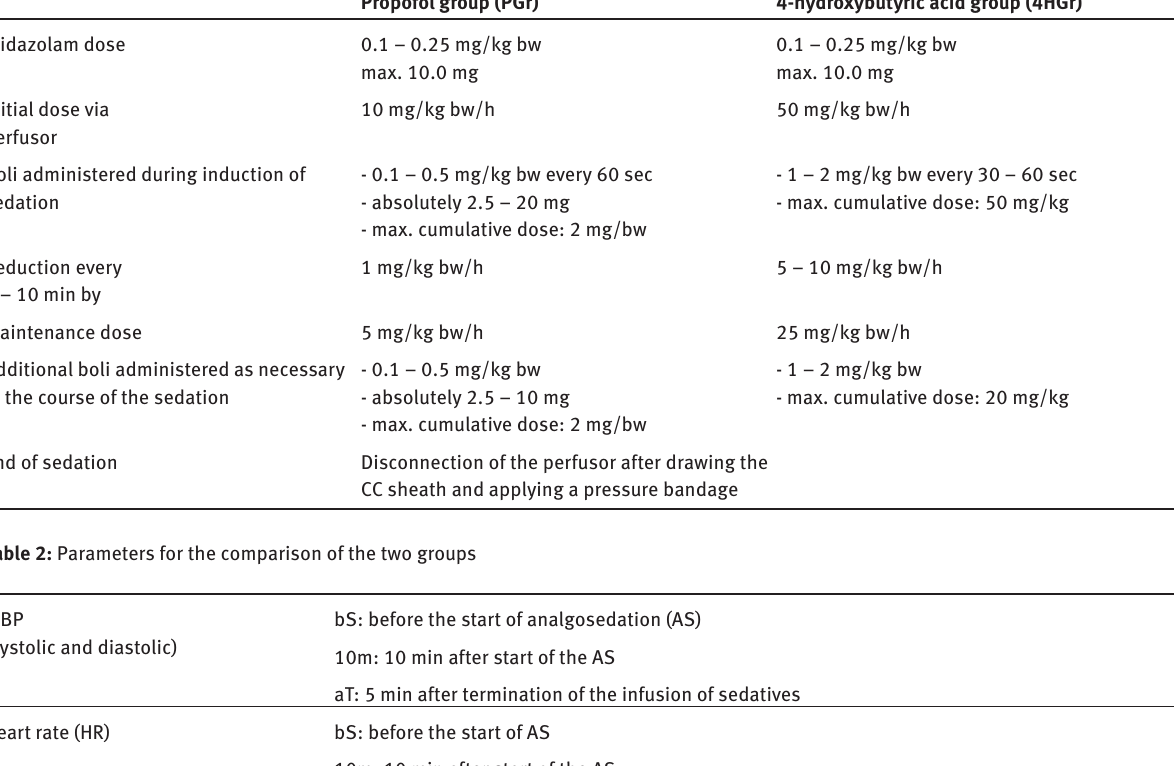
Propofol group (PGr)